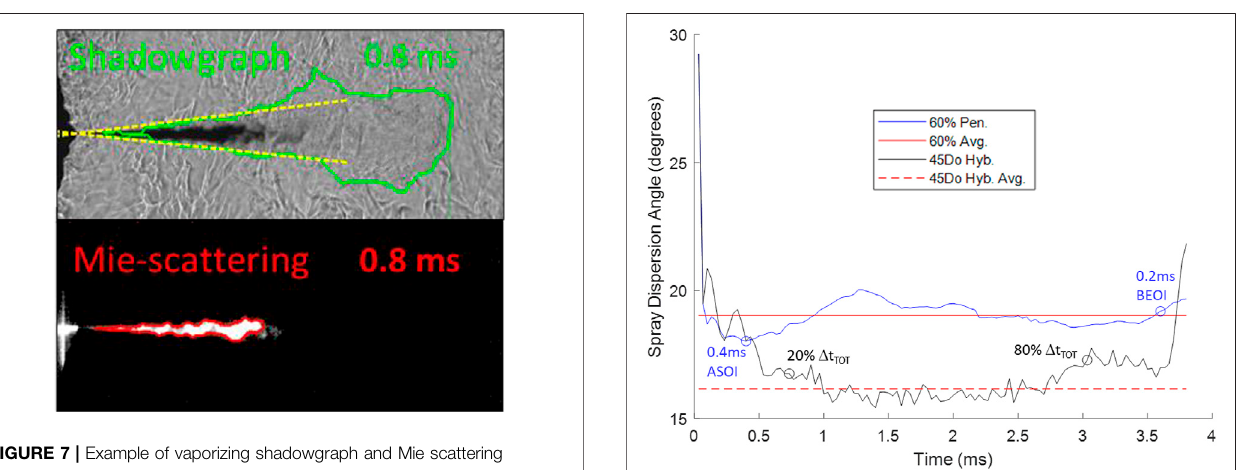
FIGURE 7 | Example of vaporizing shadowgraph and Mie scattering image spray boundary tracking (Zhang et al., 2017a).